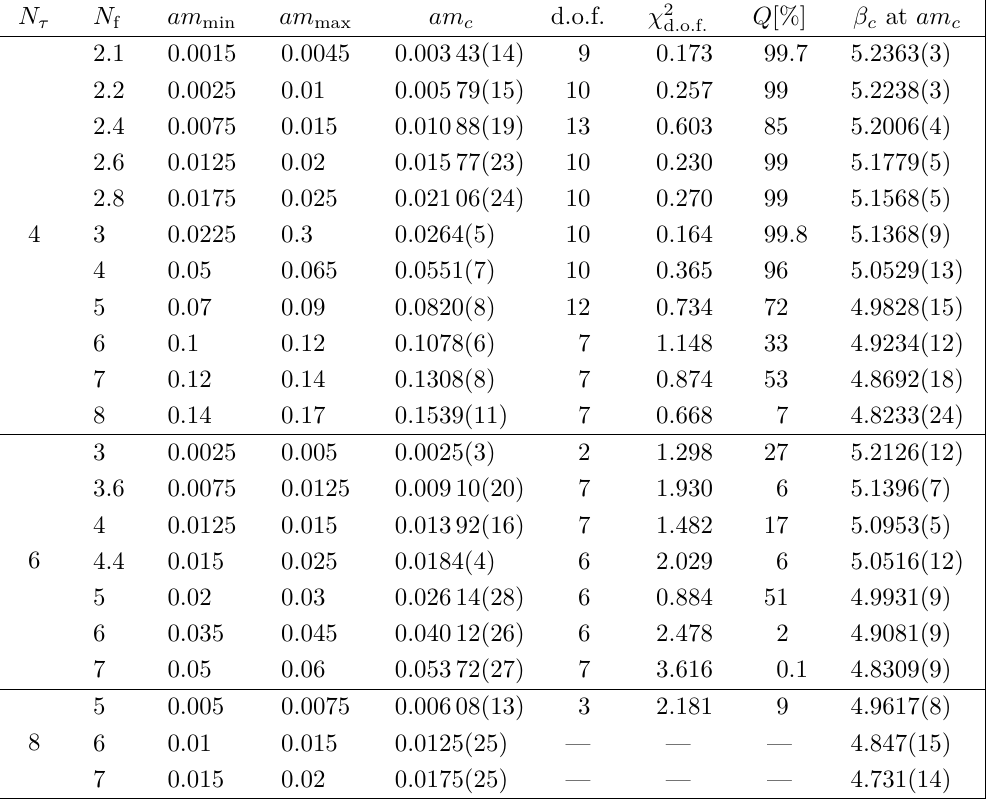
— — — 4 . 731(14) Table 1. Overview of the finite size scaling analysis and of the β c interpolation. Large values of χ 2 are due to the low number of simulated mass values and/or to the still low accumulated d.o.f. statistics. For N f ∈ { 6 , 7 } at N τ = 8 , the available data are not yet sufficient to obtain an acceptable fit, and the quoted critical mass represents the middle point of simulated masses at which the order of the transition was clear from the ordering of the kurtosis on increasing spatial lattice size, i.e. towards the thermodynamic